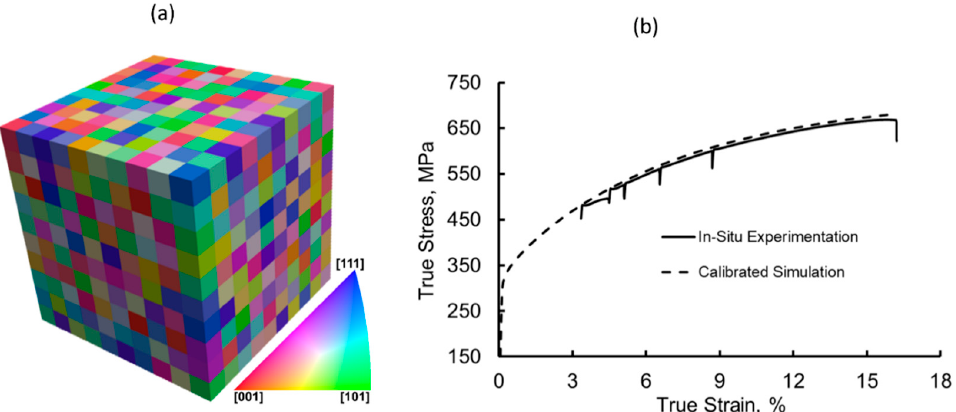
Figure 7. ( a ) 10 × 10 × 10 size RVE containing 1000 individual grain orientations, ( b ) comparison of experimental and simulation flow curves, showing a good match of results. Table 3. Elastic parameters of second phase inclusions obtained from the literature [10,20,23,26,28,41,51, 52] and calibrated parameters of ferrite adopted from the literature [23,26,28,41,52] and adjusted by comparing with the flow curve from in situ tests. The ductile damage parameters were calibrated by comparing them with the in situ test